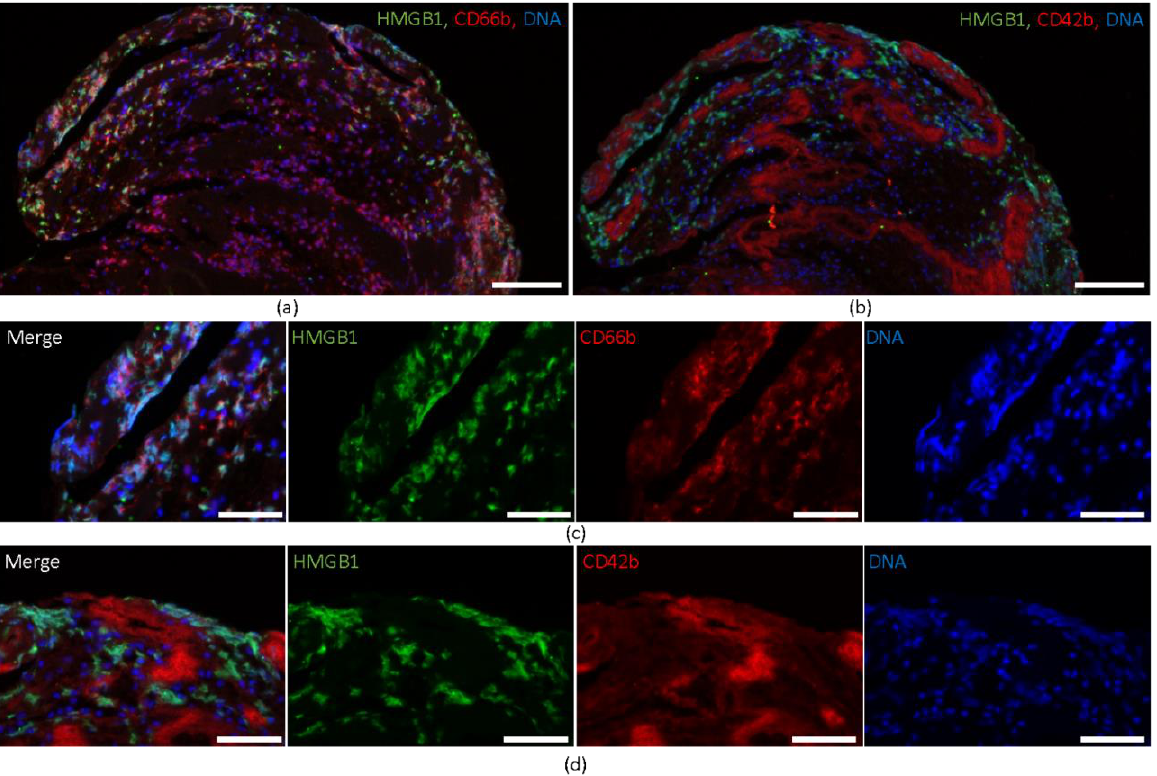
Figure 2. Immunofluorescent staining of HMGB1. Immunofluorescent co-staining identifies colocalization of ( a ) HMGB1, CD66b and DNA (by DAPI) and spatial proximity of ( b ) HMGB1 and CD42b. Representative magnifications illustrate the spatial coexistence of HMGB1 and CD66b, whereas CD42b was detected within the interspace of HMGB1-positive areas and has only marginal contact with HMGB1. Scale bars: ( a , b ) 100 µm, ( c , d ) 50 µm. HMGB 1 = high mobility group box 1, CD = cluster of differentiation, DAPI = 4,6-diamidino-2-phenylindole.